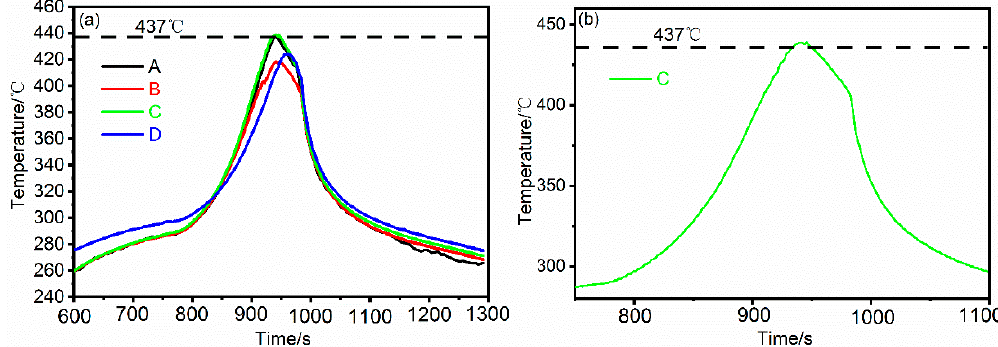
Figure 3. ( a ) The thermal cycle measured at different positions in Figure 2b near the interface of FSW joint. ( b ) The magnified thermal cycle at the position C.